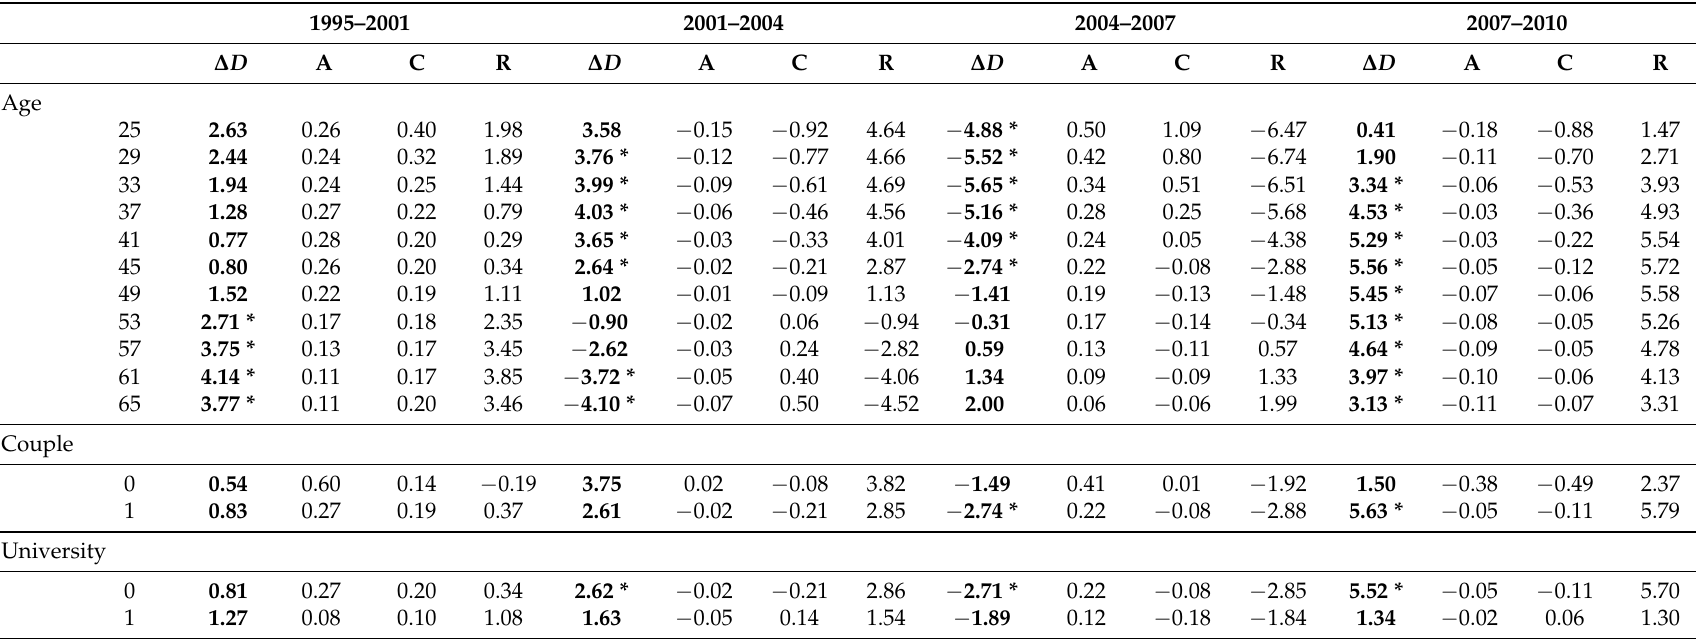
Table 6. Decomposing the Change in Arrears 1995–2013: Non-Parametric